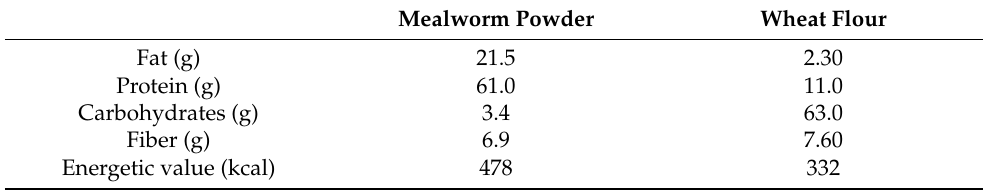
Table 6. Wheat flour and mealworm powder characterization used for bread making. Mealworm